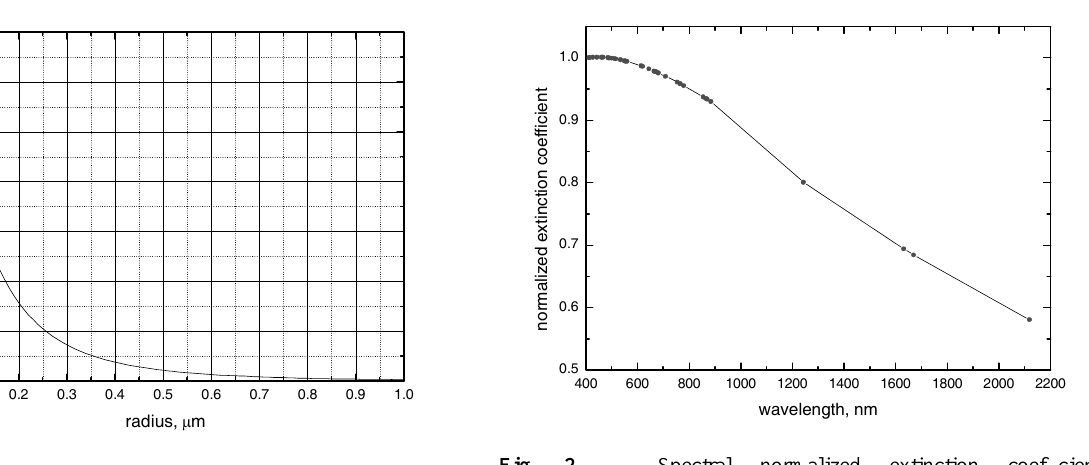
Fig. 1. Particle size distribution.